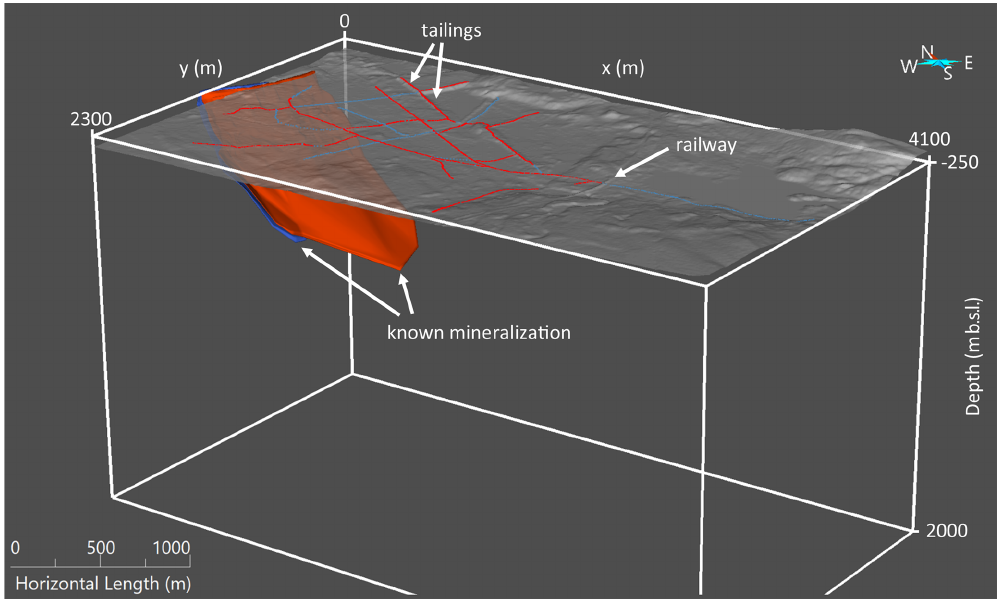
Figure 3. Perspective 3D view of the known mineralization (red and blue layers and bodies) in the Blötberget area, together with the source and receiver positions (red and blue dots, respectively) of the 3D survey and a digital elevation model showing the topography in the study